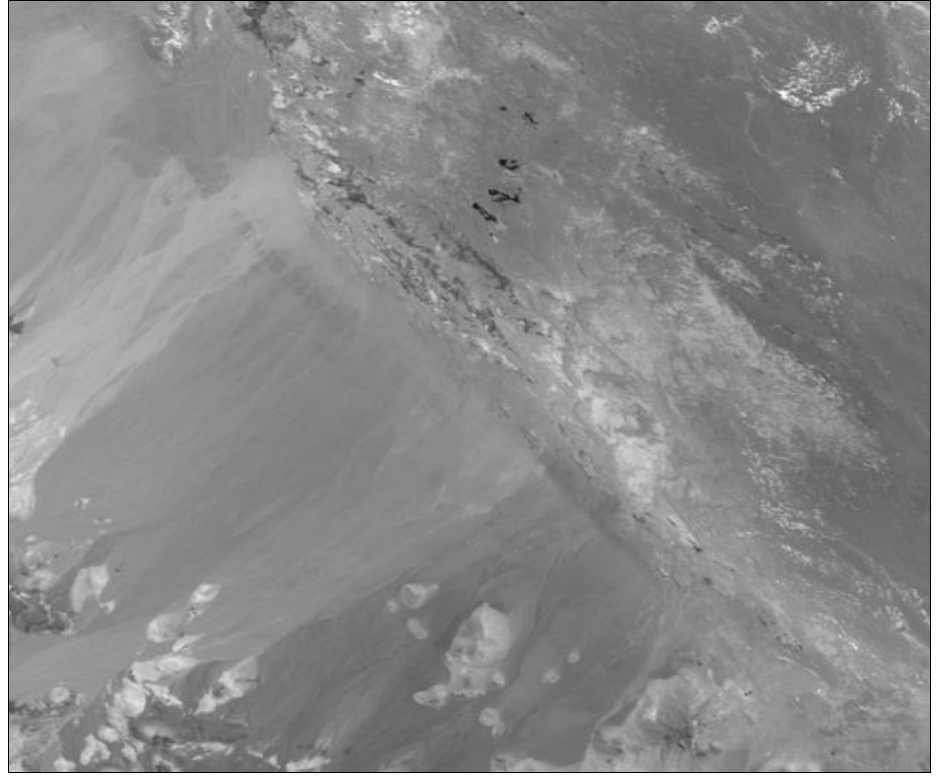
Figure 2. Lunar Lake Scene 01, Band